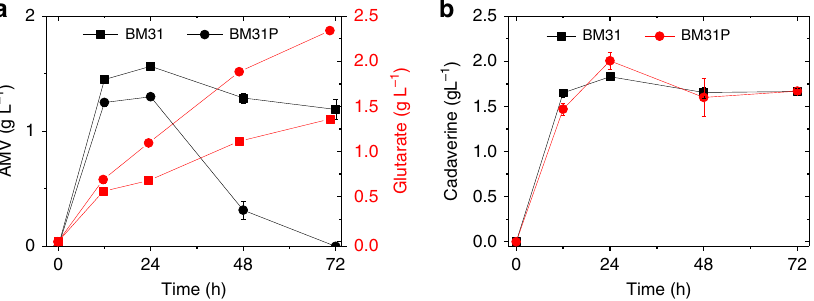
Fig. 3 Overexpression of gabP decreases AMV accumulation. Effect of gabP expression on the accumulation of a AMV and glutarate, and b cadaverine. Data shown are mean ± SD ( n = 3 independent experiments). Source data are provided as a Source Data fi